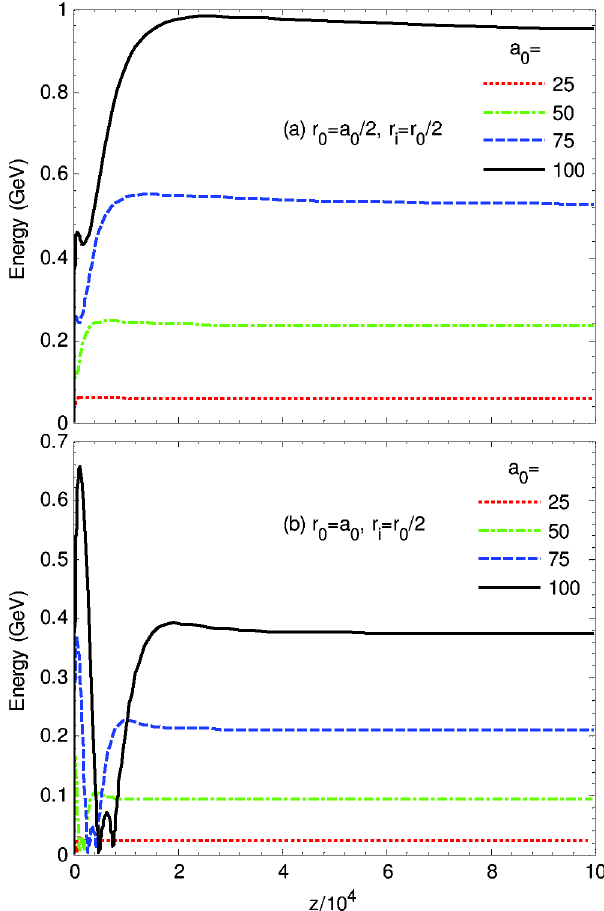
FIG. 4. Electron energy K (GeV) as a function of normalized a = 2 and (b) r a r r = 2 . Dotted, z for (a) r 0 ¼ 0 0 ¼ 0 for i ¼ 0 dashed, dot-dashed, and solid lines are for a 0 ¼ 25 , 50, 75, and 100, respectively. The parameters are (cid:3) ¼ 200 , z L ¼ 0 , and t 0 ¼ 0